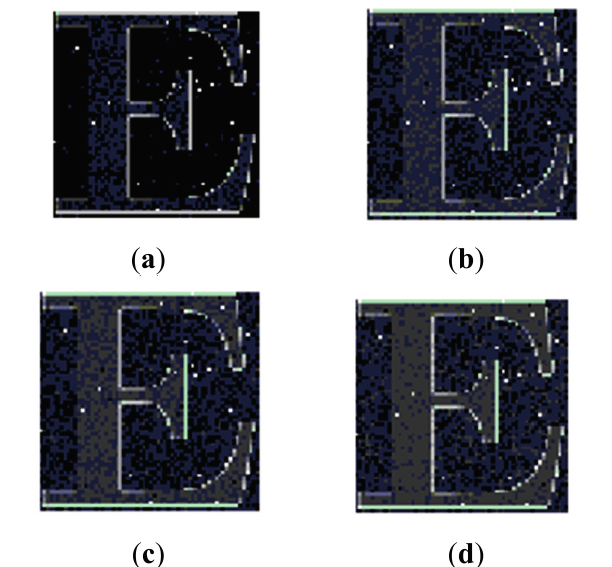
Figure 9. Photos taken by the fabricated 64 × 64 test image sensor with different body bias